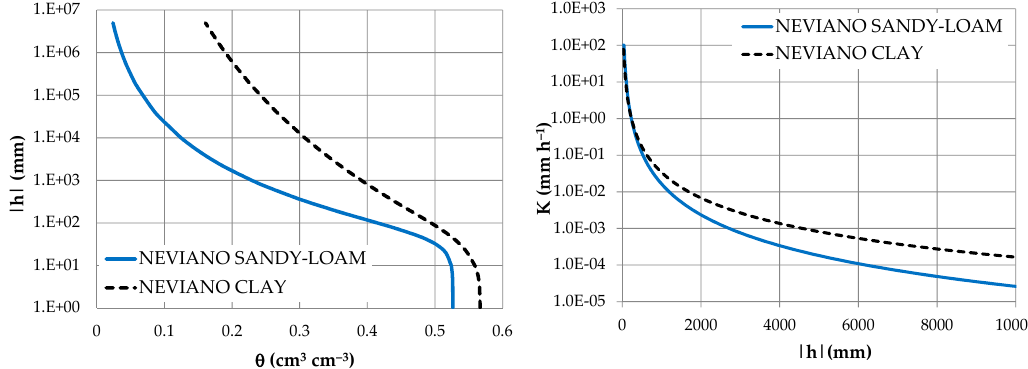
Figure 6. Soil water retention curve and hydraulic conductivity function (left and right, respectively) obtained at the Neviano site.